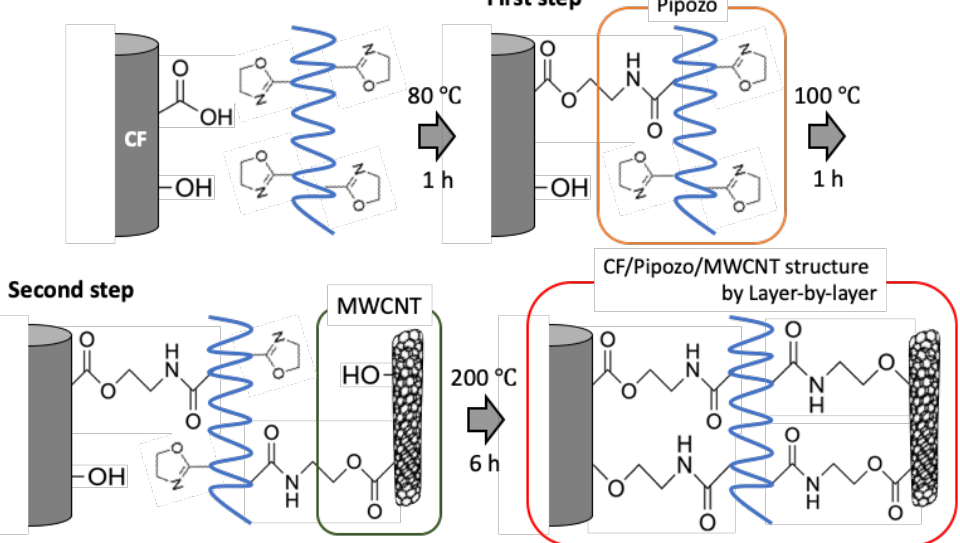
Figure 1. Schematic illustration of layer-by-layer coating Pipozo and MWCNTs onto CF surfaces by chemical reaction. chemical